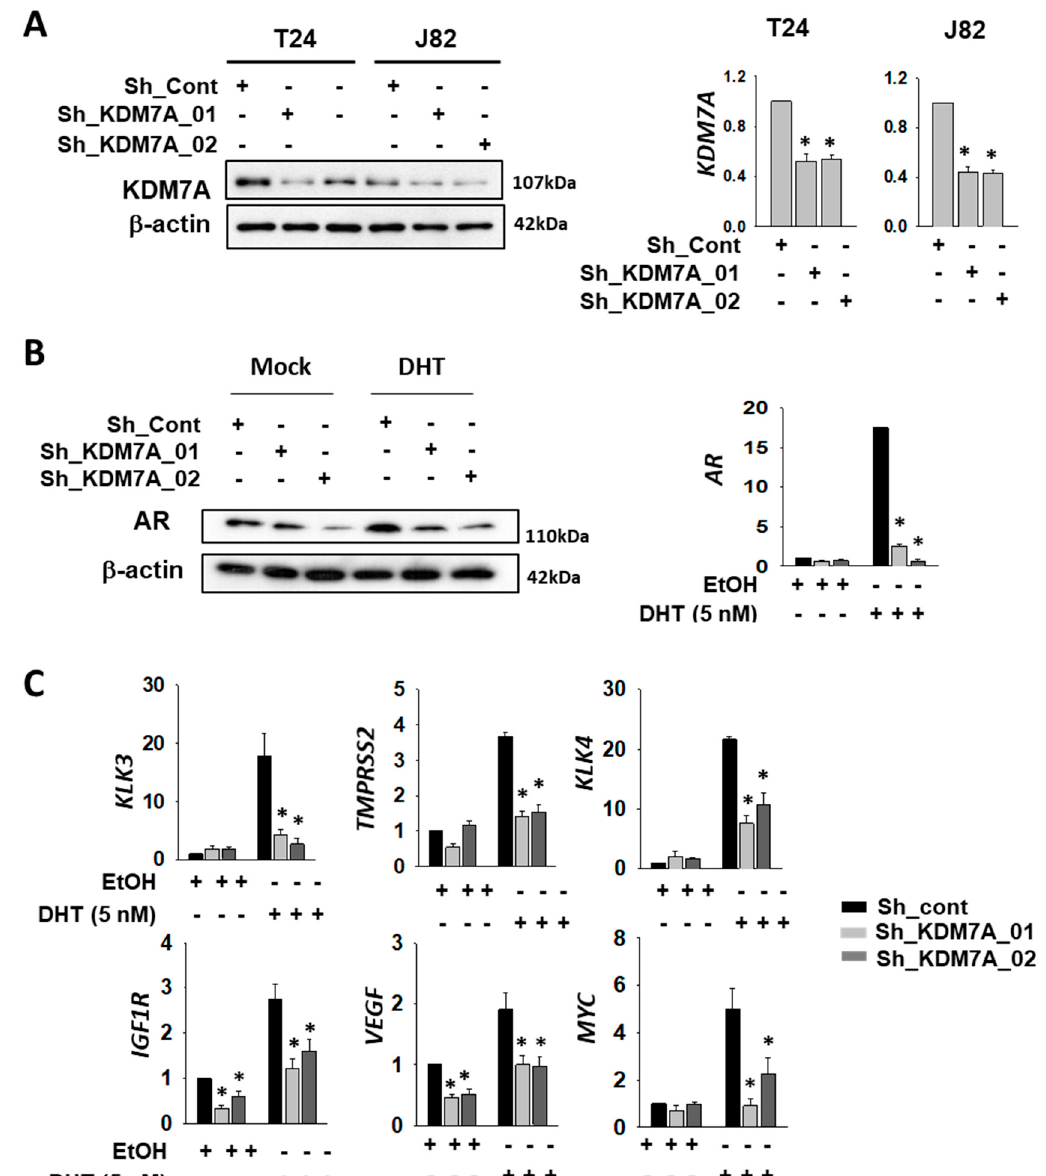
Figure 1. Histone demethylase KDM7A is required for AR activity in bladder cancer cells. ( A ) The efficiency of KDM7A knock-down was measured by comparing protein levels of KDM7A in the indicated cell lines, expressing control or two different shRNAs. Whole-cell lysates were analyzed with the indicated antibodies (left). The mRNA levels of KDM7A were measured by RT-qPCR method in the KDM7A knock-down cell lines (right graphs). Bars represent the means ± SD of three independent experiments, and * denotes p < 0.05 (student t -test) versus the control shRNA (sh-cont) group. ( B ) The AR protein levels in KDM7A knock-down T24 cells treated with dihydrotestosterone (DHT) were analyzed with indicated antibodies (left). The mRNA levels of AR in T24 cells after DHT induction were measured by RT-qPCR (right graph). Bars represent the means ± SD of three independent experiments, and * denotes p < 0.05 (student t -test) versus the control shRNA (sh-cont) group. ( C ) The mRNA levels of AR downstream genes were measured by RT-qPCR method in KDM7A knock-down T24 cell lines. Bars represent mean ± SD of three independent experiments. * p < 0.05 (Student’s t -test), versus the control shRNA (sh-cont) group.